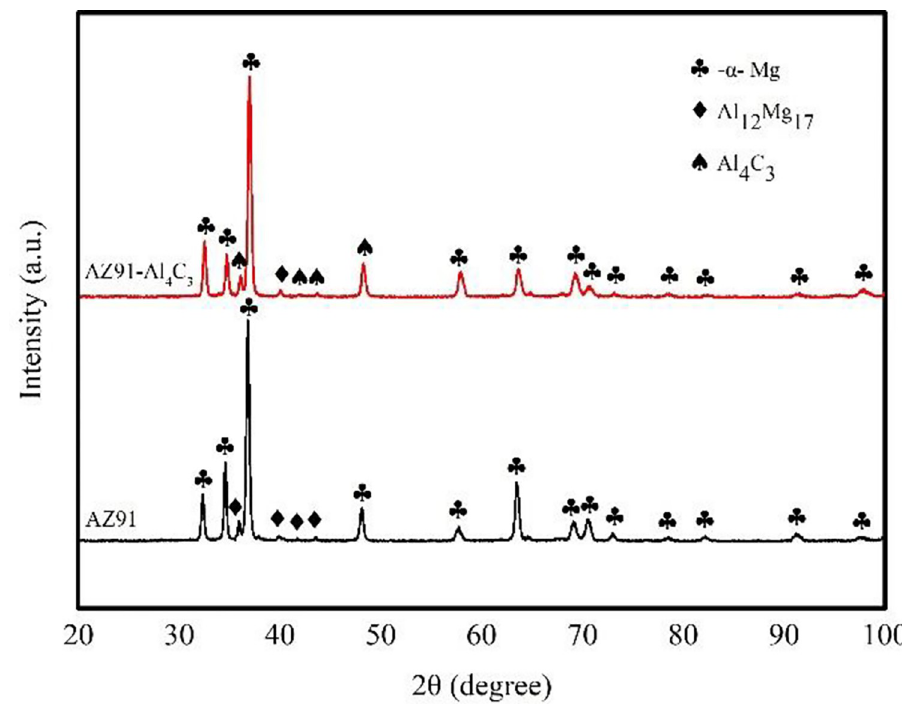
Fig 7. XRD analysis of AZ91